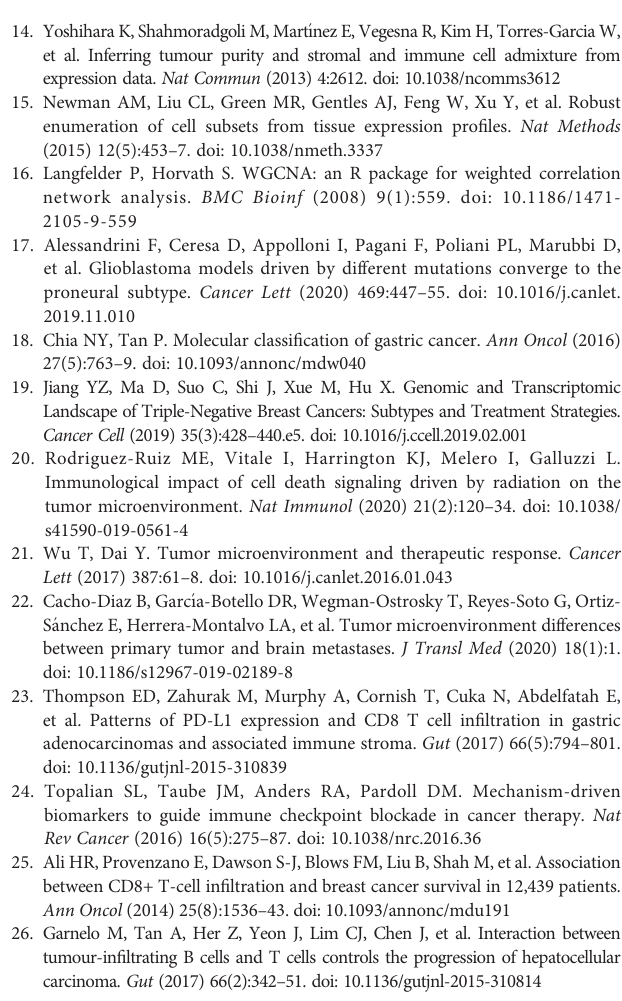
SUPPLEMENTARY TABLE 2 | GO terms enriched in Immunity_H and Immunity_L. GO, gene